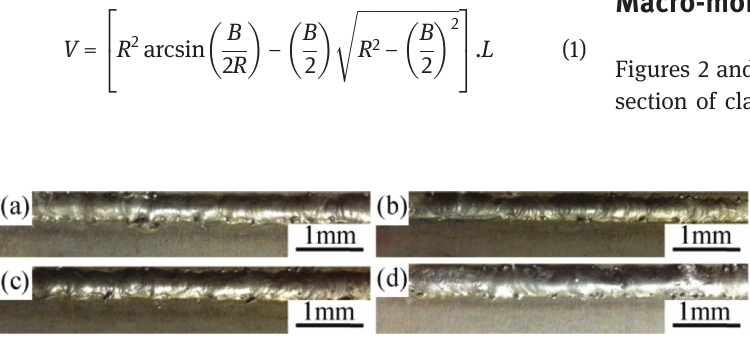
Figure 2: Macro-morphology of the composite coatings: (a) 0%; (b) 2%; (c) 4% and (d) 6%.